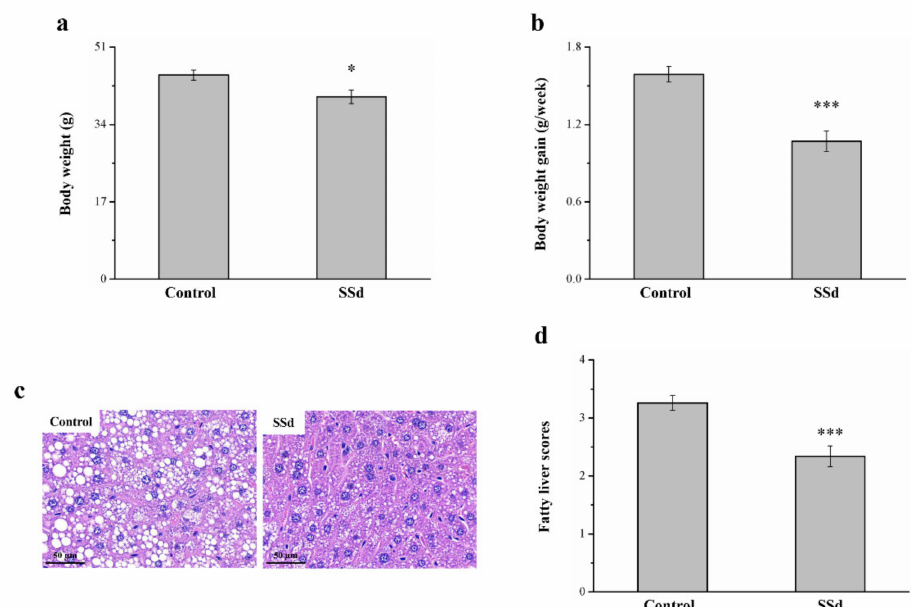
Figure 7. Changes in ( a ) body weight and ( b ) weekly body weight gain in the HFD-fed control and SSd groups. ( c ) H&E- stained liver tissue sections of control and SSd groups and ( d ) fatty liver scores of control and SSd groups over 8 weeks. All data are reported as means ± SD (n = 8). * p < 0.05; *** p < 0.001.